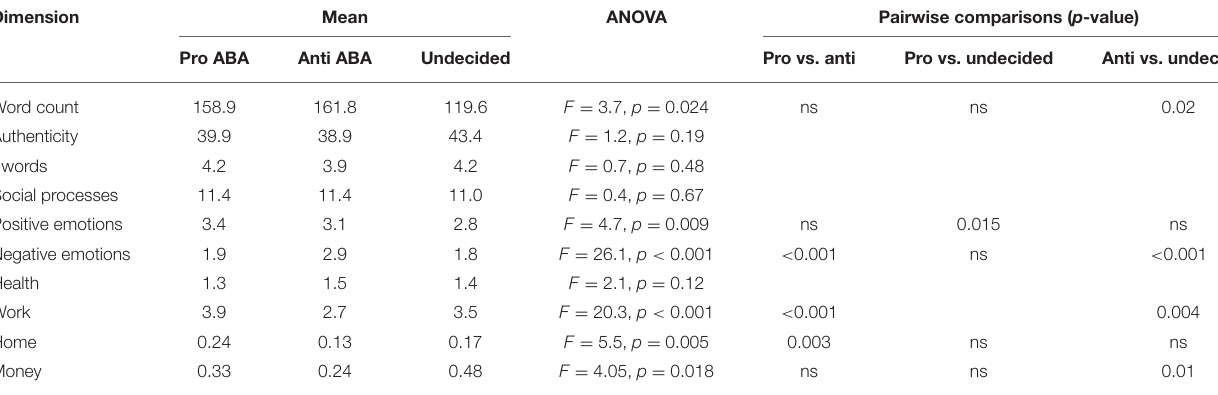
TABLE 4 | LIWC across user categories based on view toward ABA. Dimension Mean ANOVA Pairwise comparisons ( p -value) Anti ABA Undecided Pro vs. anti Pro vs. undecided Anti vs. undecided